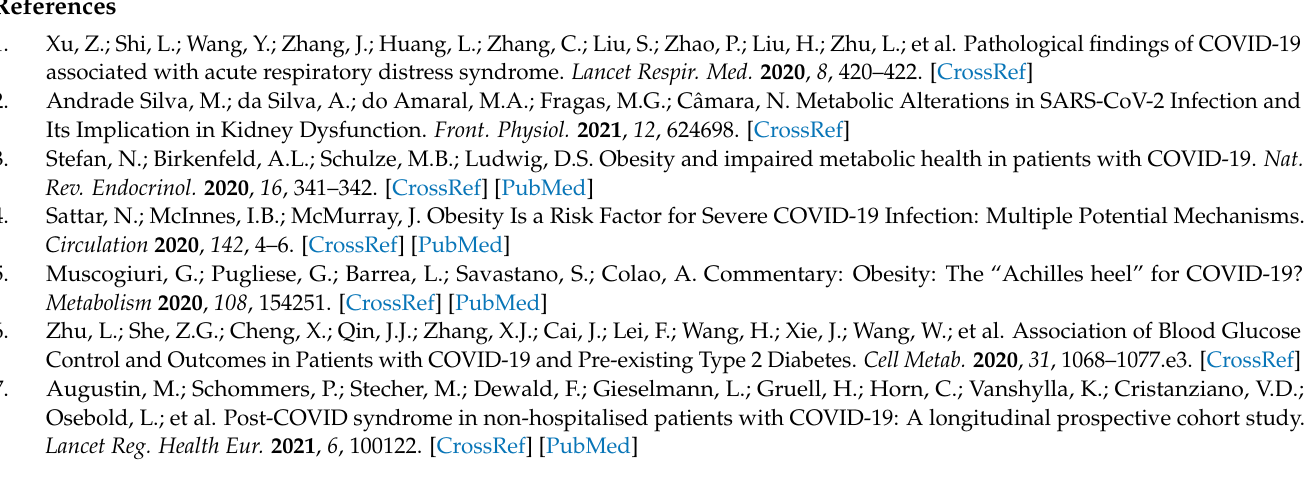
Figure 2. Main targets of recommended dietary compounds in patients with post-COVID-19 syn- drome.